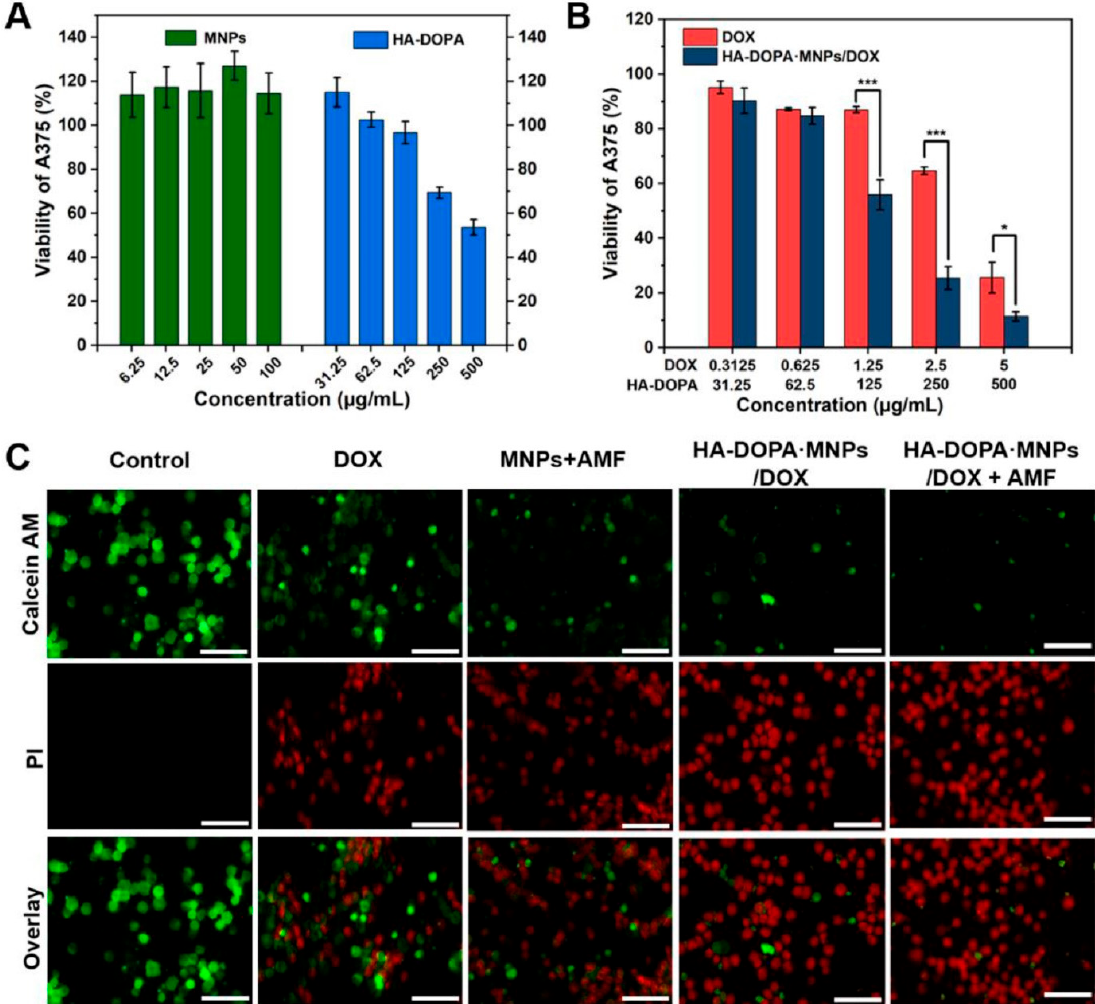
Figure 11. ( A ) Viabilities of human melanoma cells (A375) after 24 h of treatment with MNPs and an injectable hydrogel made of dopamine-conjugated hyaluronan (HA-DOPA). ( B ) Viabilities of A375 cells after 24 h of treatment with an anti-cancer drug (doxorubicin; DOX) and an anti-cancer-drug-loaded hydrogel. ( C ) Fluorescence images of A375 cells with staining of calcein AM (AM, green, live cells) and propidium iodide (PI, red, dead cells) after various treatments. The images show how magnetic fields and anti-cancer drugs both act on cell death. Scale bar: 100 µm [155] .